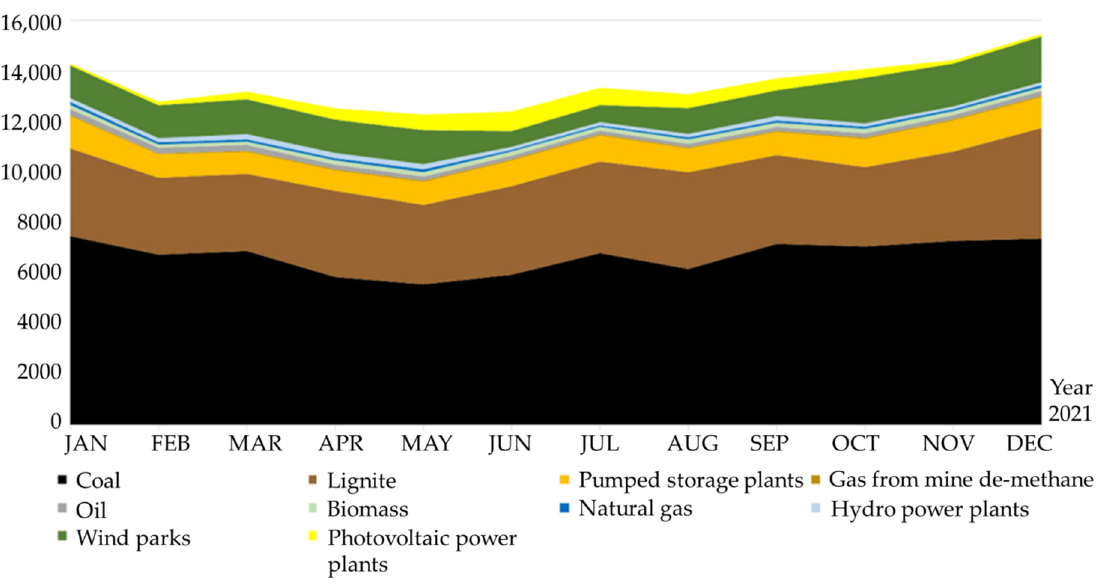
Figure 7. Electricity production in Poland in 2021 (GWh).